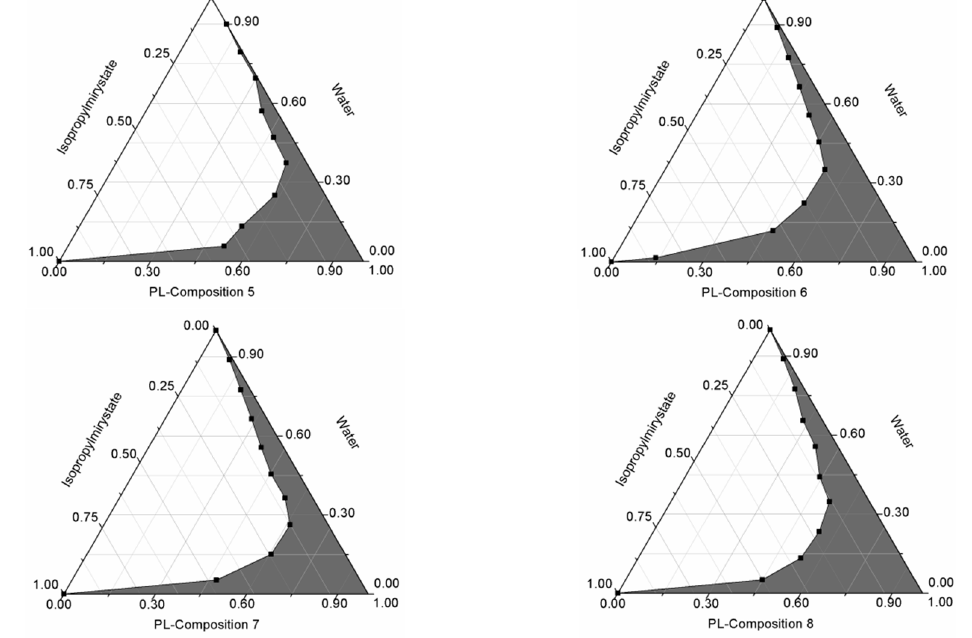
Figure 1. Pseudoternary phase diagrams of compositions 1 – 8 . (Shaded areas represented nanoemulsions).